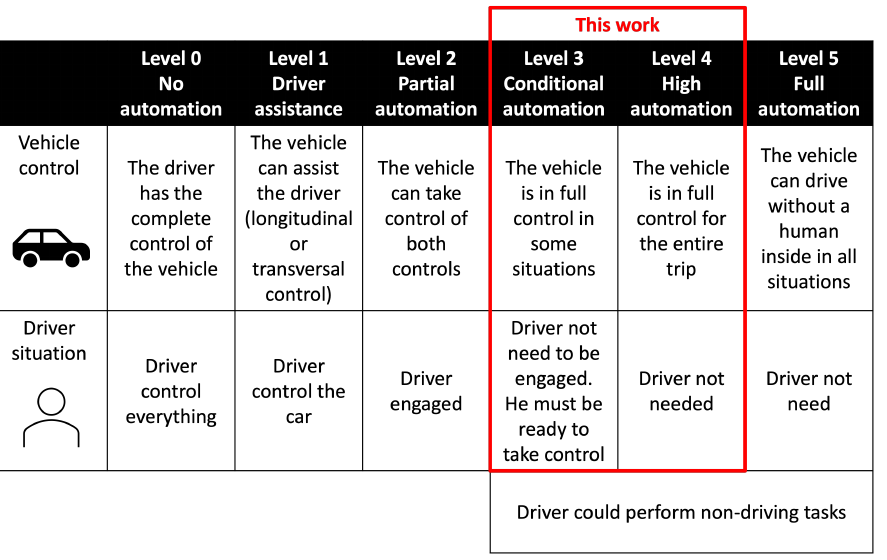
Figure 1. Automation levels, with the level of attention required by the